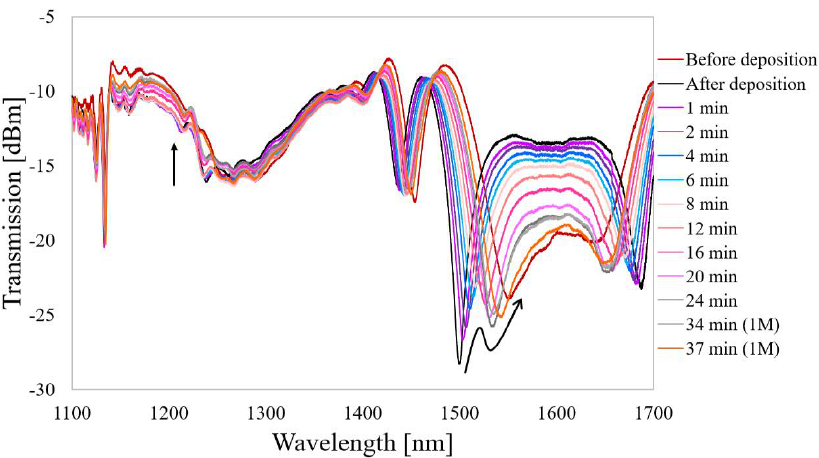
Figure 7. The response of LPG-µIMZI to Al 2 O 3 film etching recorded for measurements in water. The plot shows the evolution of the transmission spectrum during the process of the response before the deposition. Due to the low effectiveness of the etching process, the last two etching rounds were performed in 1M NaOH.